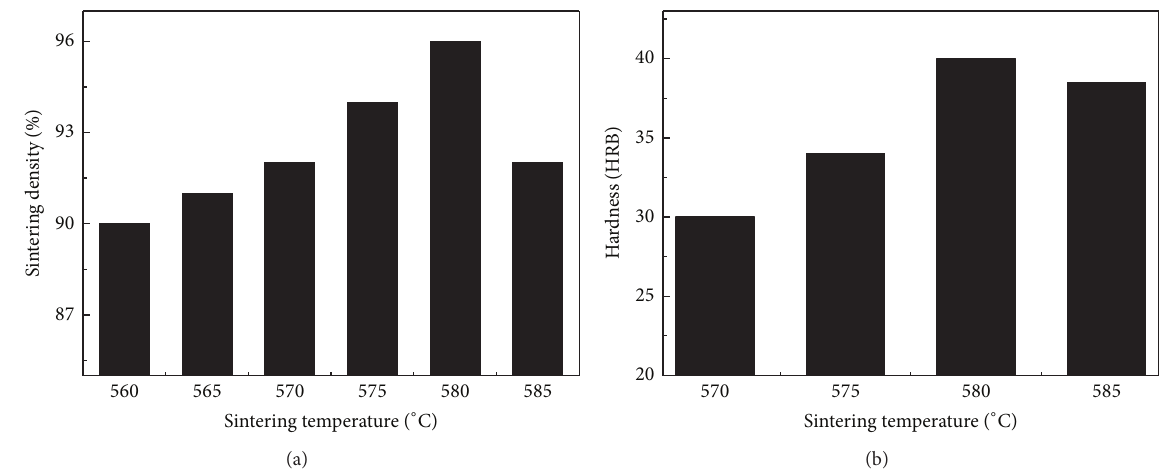
Figure 3: (a) Sintering density and (b) HRB hardness as a function of sintering temperature for Alumix 431D powder, and it seems that 580 ∘ C is an optimum sintering temperature.